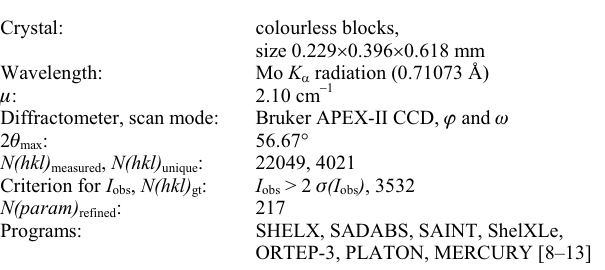
Table 1. Data collection and handling.